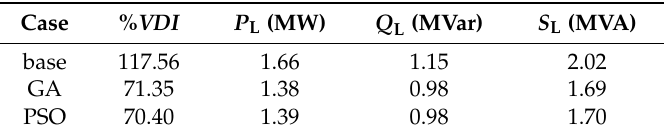
Table 2. System performance